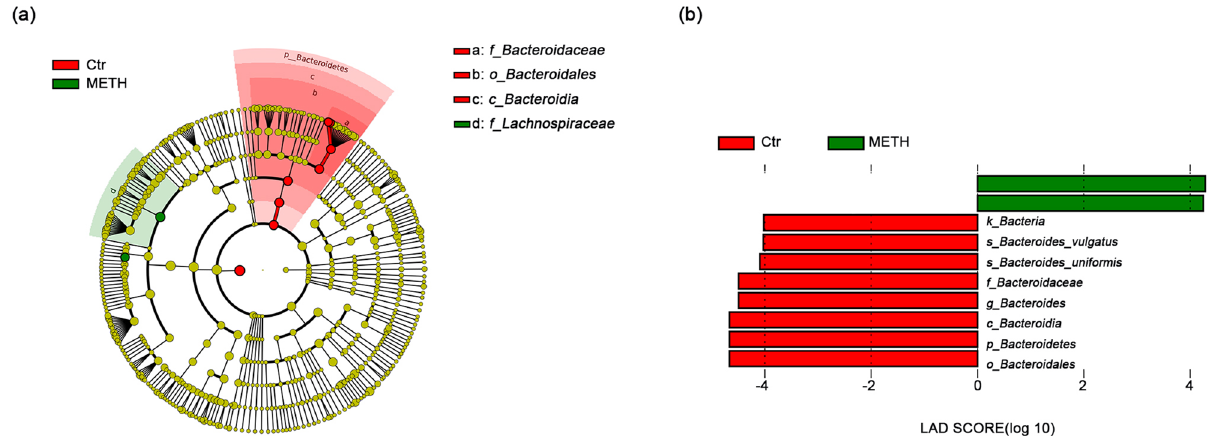
Figure 3. Taxonomic representation of significant differences in relative abundances between the METH and Ctr groups. ( a ) Cladograms generated by LEfSe indicating differences in the bacterial taxa between the subjects with METH use disorder (METH) and the control (Ctr) subjects. Nodes in red indicate taxa that were enriched in the Ctr compared to the METH group, while nodes in green indicate taxa that were enriched in the Ctr compared to the METH group. ( b ) LDA scores for the bacterial taxa with differential abundances between the METH and Ctr groups. Positive and negative LDA scores indicate bacterial taxa enriched in the METH and Ctr groups, respectively. Only the taxa with p < 0.01 (Wilcoxon rank-sum test) and LDA > 4.0 are shown in the figure